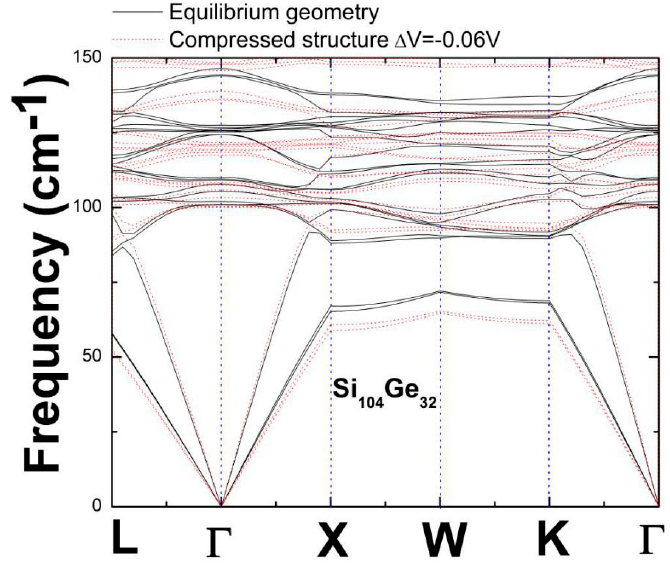
Figure 7. Low-frequency dispersion relationship curves of Si 104 Ge 32 in the Brillouin zone, for the optimized geometry (black solid line) and compressed configuration (red dotted line). Table 1. Calculations of the mode Grüneisen parameters for the theoretically studied Si 136- x Ge x ( x = 8, 32).